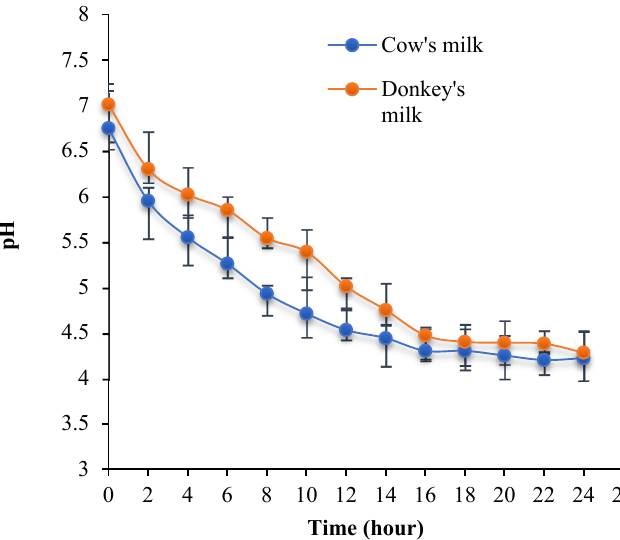
Figure 1. pH evolution of cow and donkey milks during fermentation with kefir grains at 25 °C.